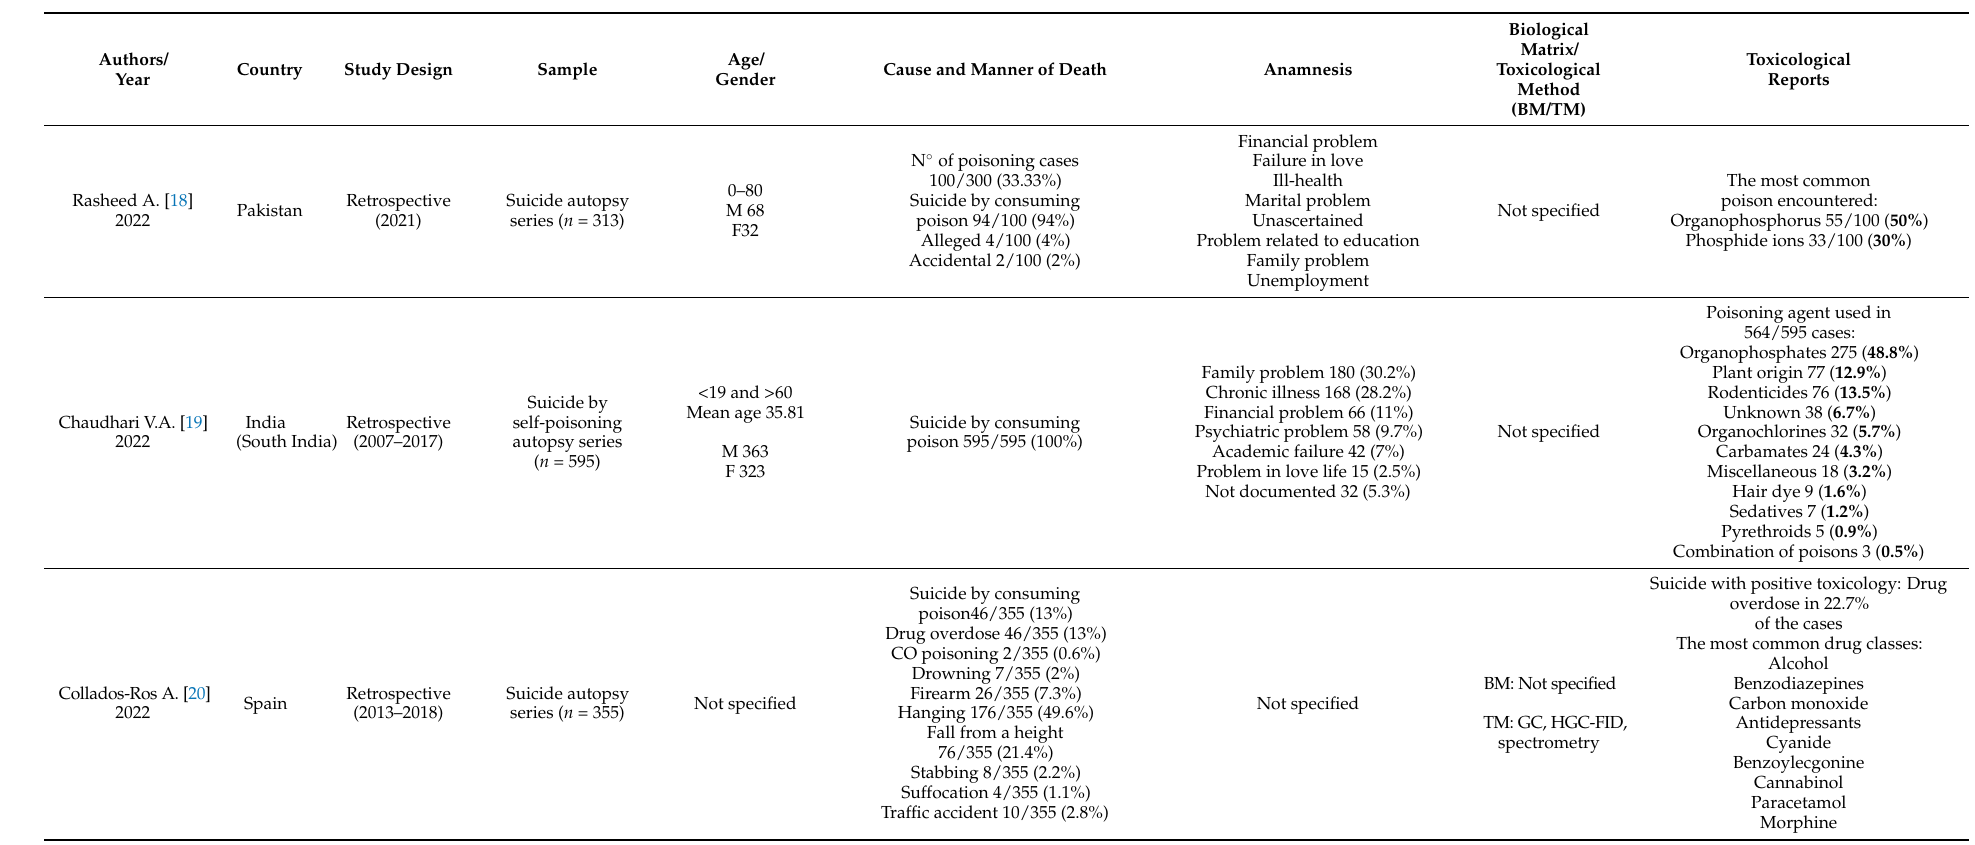
Table 1. Summary of the systematic review (ELISA: enzyme-linked immunosorbent assay; EMIT: enzyme-multiplied immunoassay technique; GC: gas chromatog- raphy; GC-ECD: gas chromatography-electron capture detection; GC-FID: gas chromatography–flame ionization detection; GC-MS: gas chromatography–mass spectrometry; GC-NP: gas chromatography nitrogen–phosphorus; GC-NPD: gas chromatography-nitrogen phosphorus detection; GS-FID: gas